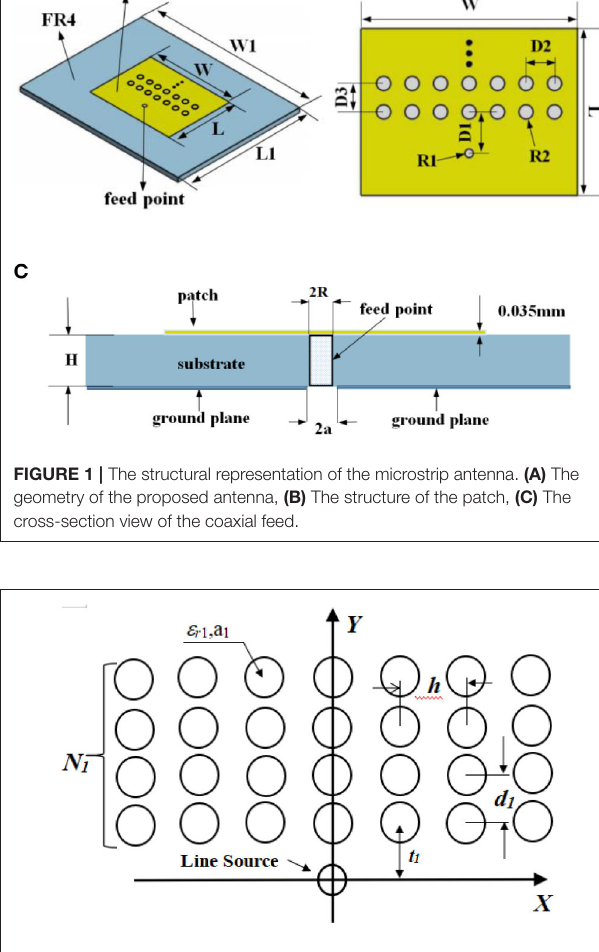
FIGURE 2 | Scheme of a localized Y line source embedded at the origin of the coordinate system of bounded two-dimensional photonic